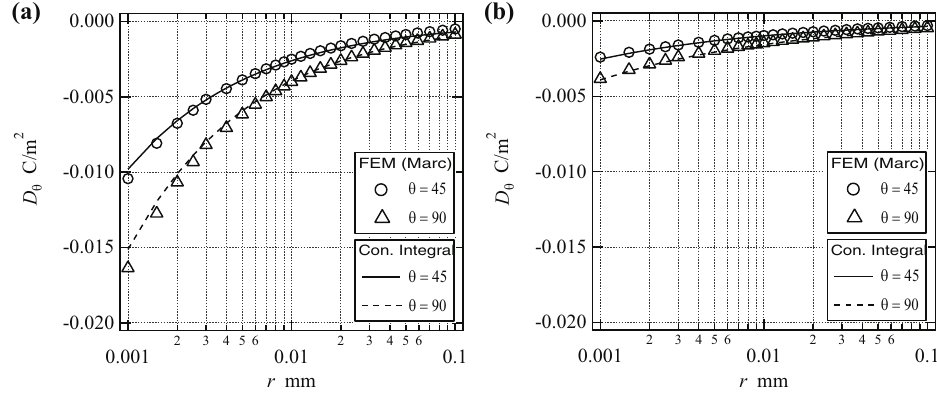
Figure 9: Distribution of electric displacements, D θ , at ϕ = 45° and θ = 45° and 90° with respect to r : ( a ) Vertex - 1 and ( b ) Vertex - 2.